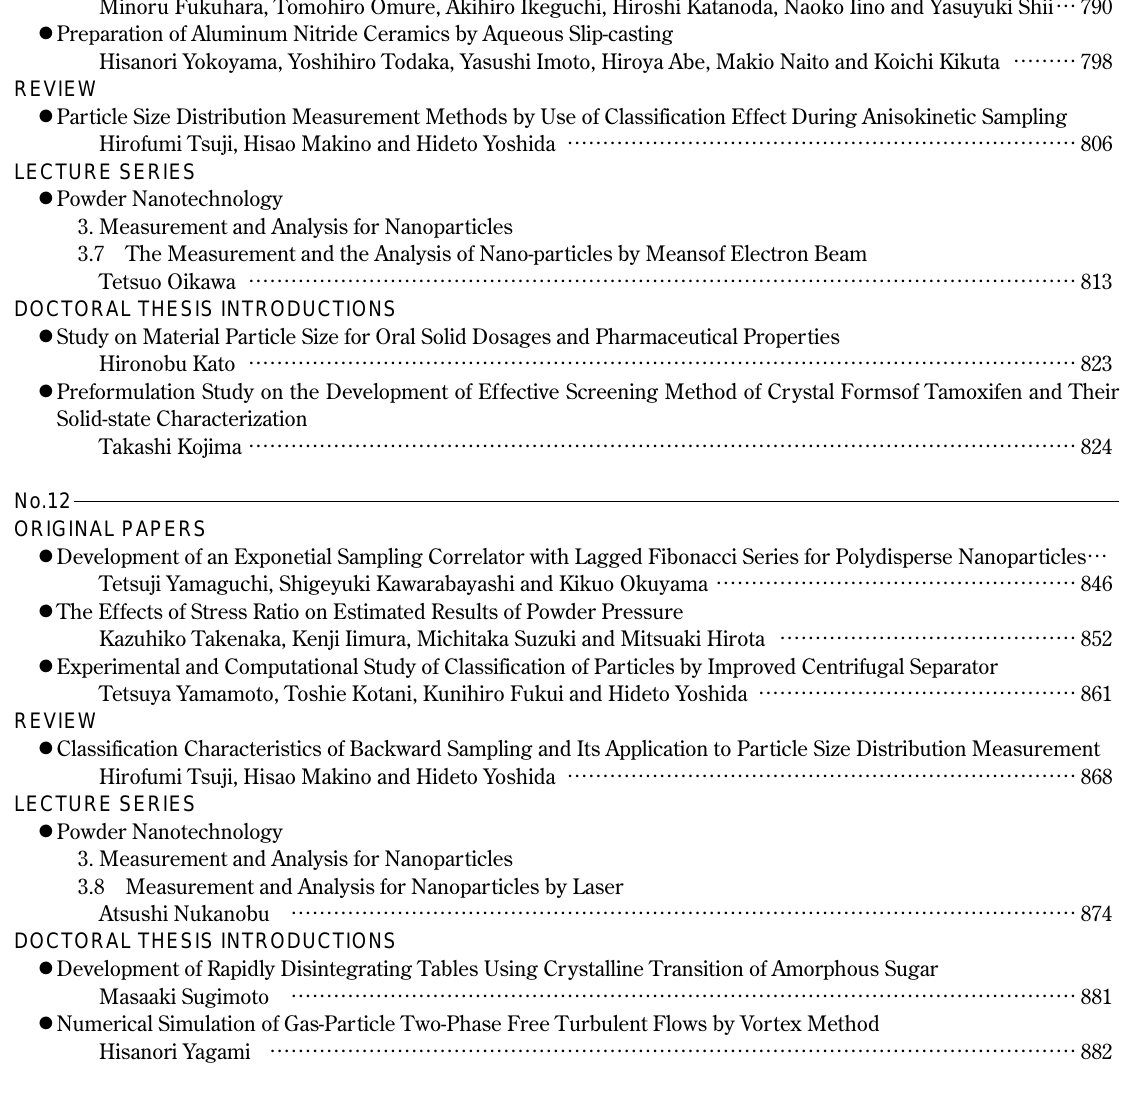
・ Effect of Adding Methods of Neutralizer on Rheological Behavior of Alumina Water-base Suspension and Properties of Green Sheets Using Acrylic Polymer ・ Effect of Pipe Diameter Ratio on Pneumatic Conveying Characteristics of Suction Nozzle with Injection Pipe Minoru Fukuhara, Tomohiro Omure, Akihiro Ikeguchi, Hiroshi Katanoda, Naoko Iino and Yasuyuki Shii … 790 ・ Preparation of Aluminum Nitride Ceramics by Aqueous Slip-casting